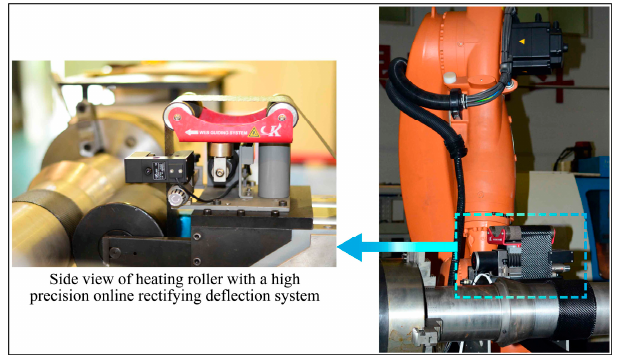
Figure 2. Automate tape winding KUKA robot (XGD-1200).